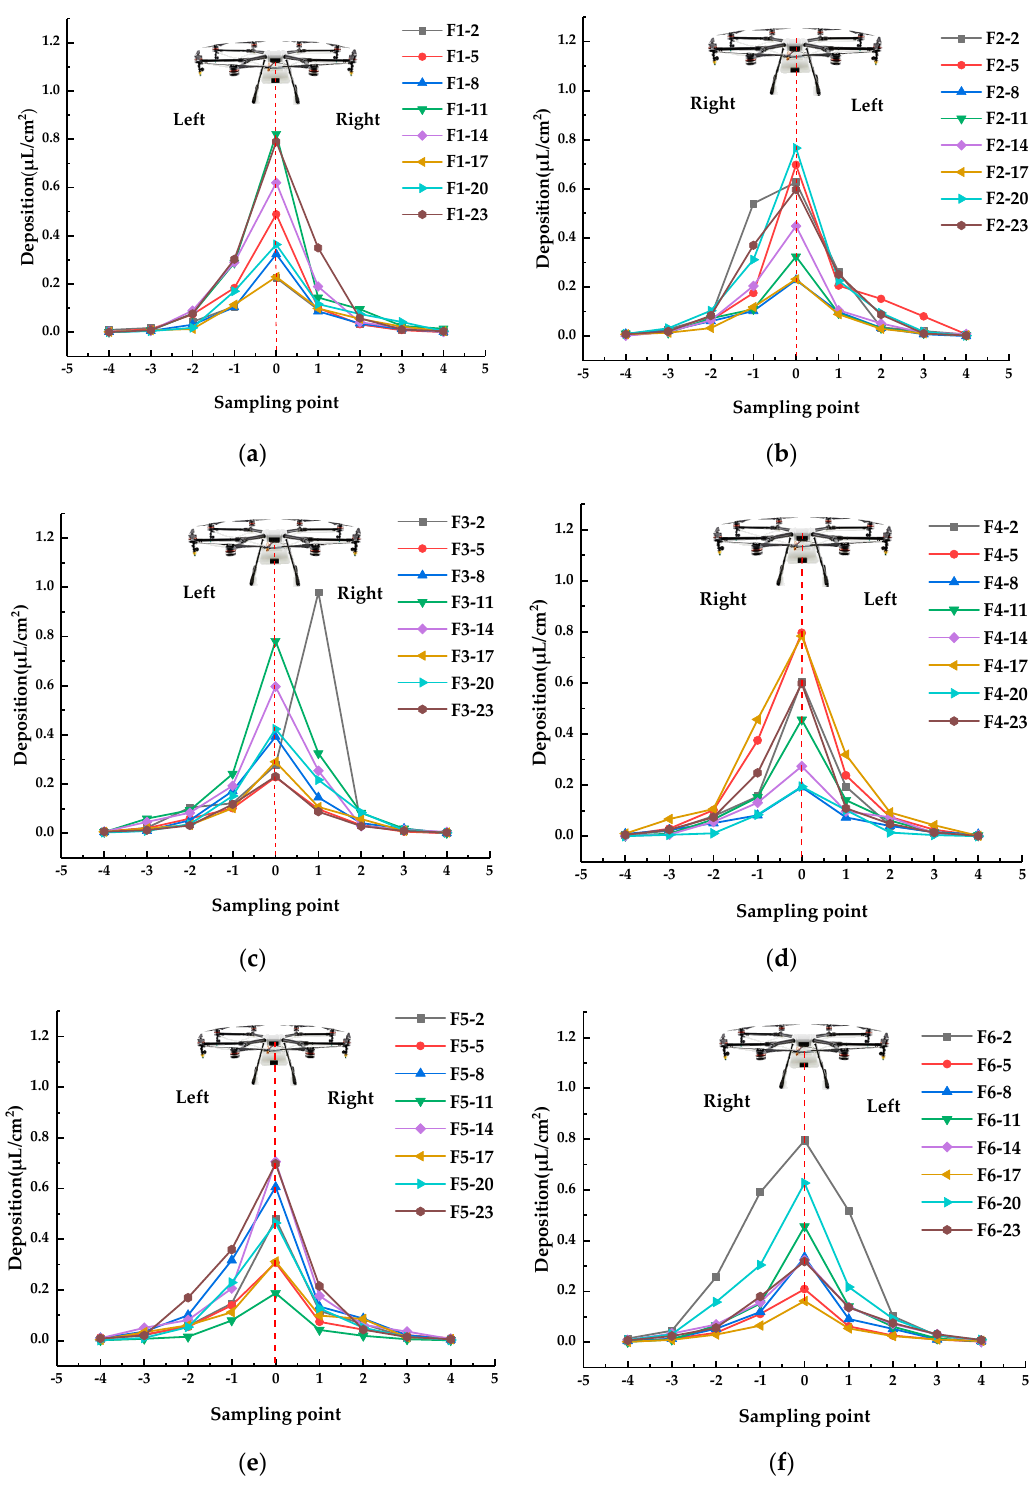
Figure 18. Droplet deposition at different sampling points at the center line of operation unit. ( a ) Route F1. ( b ) Route F2. ( c ) Route F3. ( d ) Route F4. ( e ) Route F5. ( f ) Route F6.